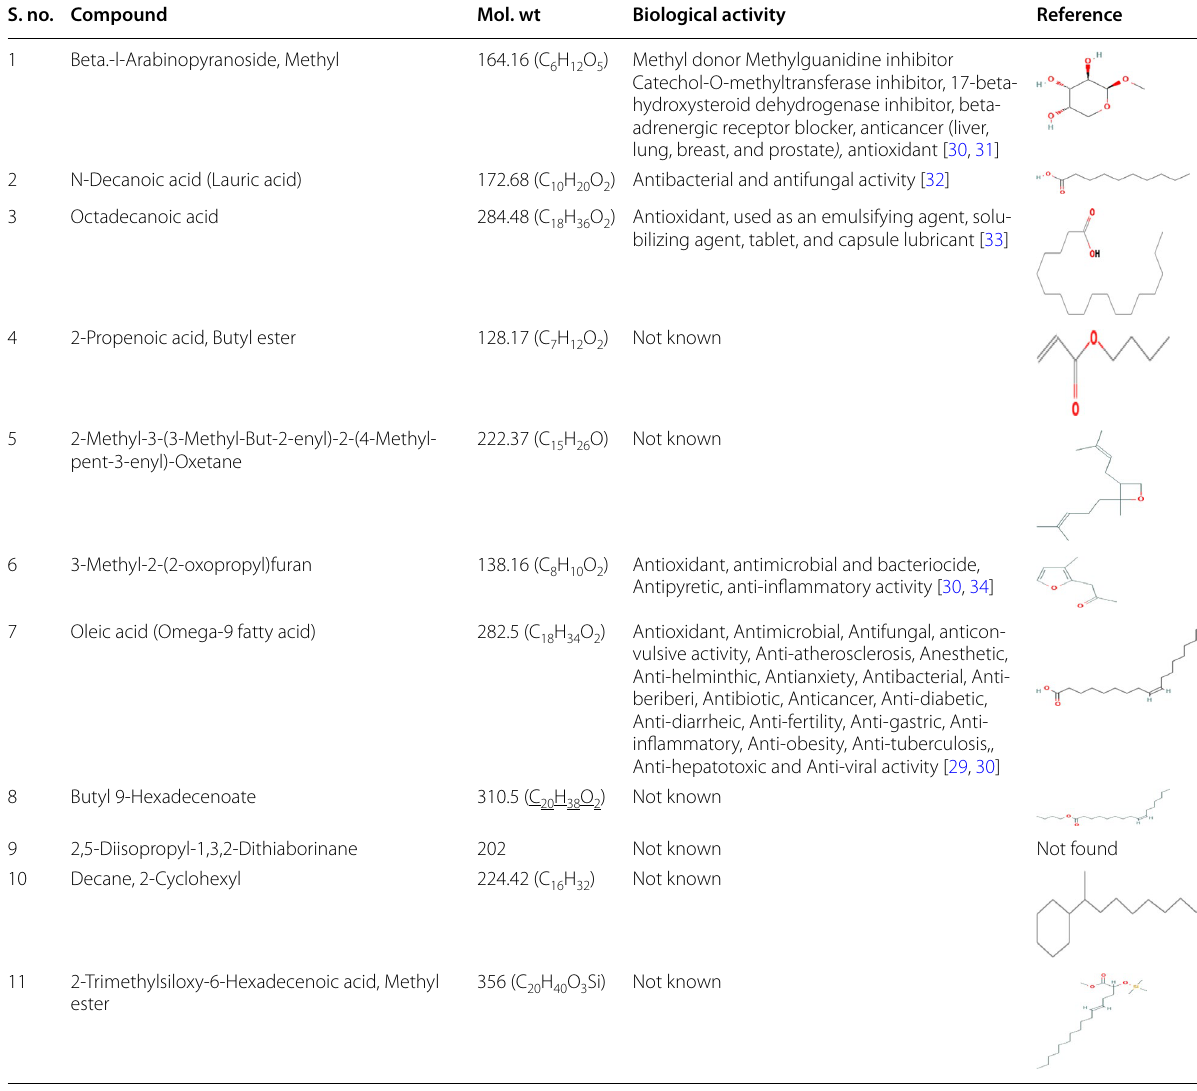
Table 6 Phytocompounds identified in the methanol extract using GCMS with their structure and biological activity S. no. Compound